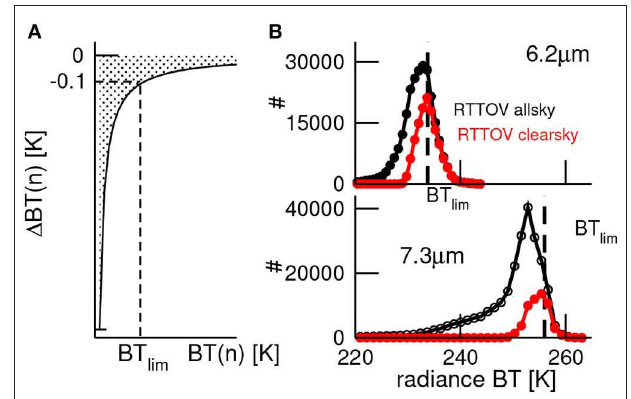
FIGURE 1 | Estimation method for limit brightness temperature BT lim . (A) Illustration of distribution 1 BT (Equation 6) with respect to brightness temperature BT. (B) Examples of histograms for all data BT as ( allsky ) and selected data for which 1 BT( n ) > − 0.1 K ( RTTOV clearsky in red color). The panels show data for SEVIRI infrared channels 7.3 µ m and 6.2 µ m in the time window June 6, 2016–June 10, 2016. Here, the estimated limit brightness temperature is BT lim = 256.3 K (7.3 µ m) and BT lim = 234 K (6.2 µ